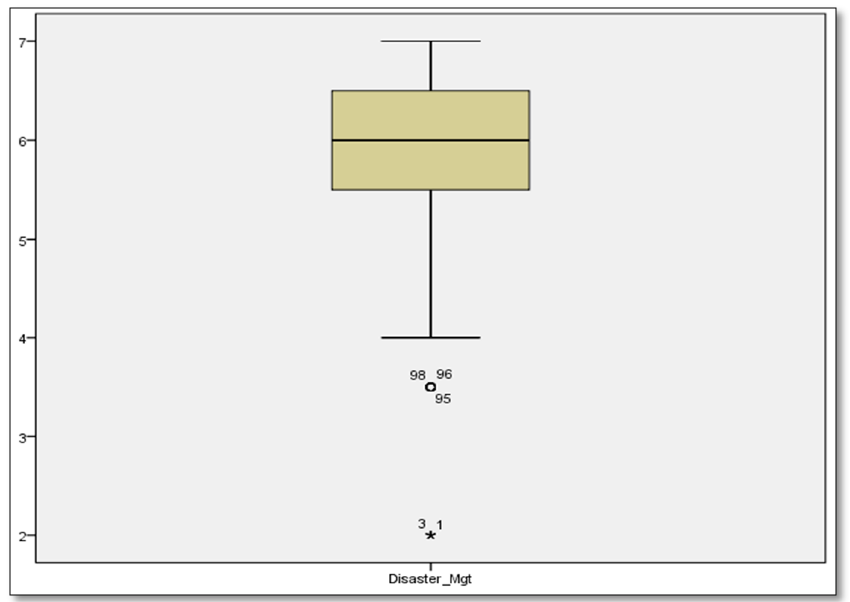
Figure 7. Box plot for outliers (Source: Sample data).